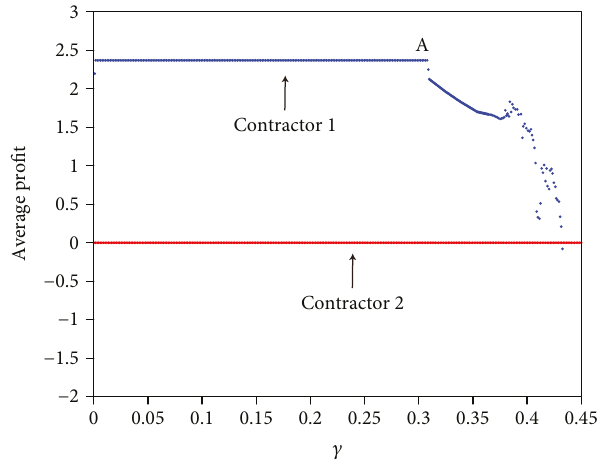
Figure 7: Average pro fi t in situation